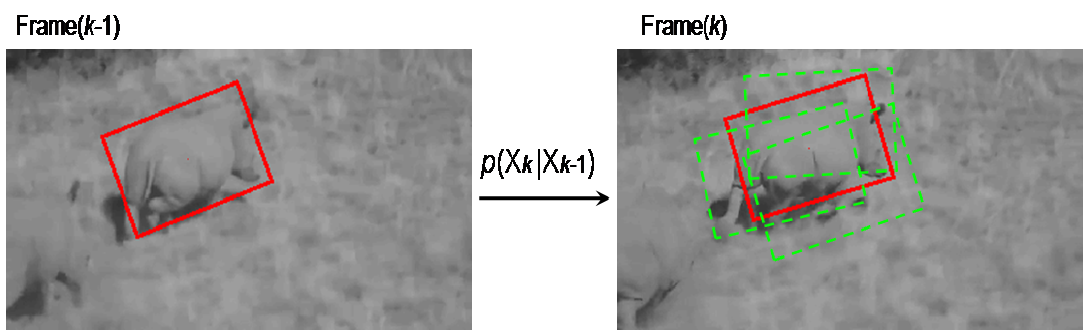
Figure 2. The dynamic model of visual rhino